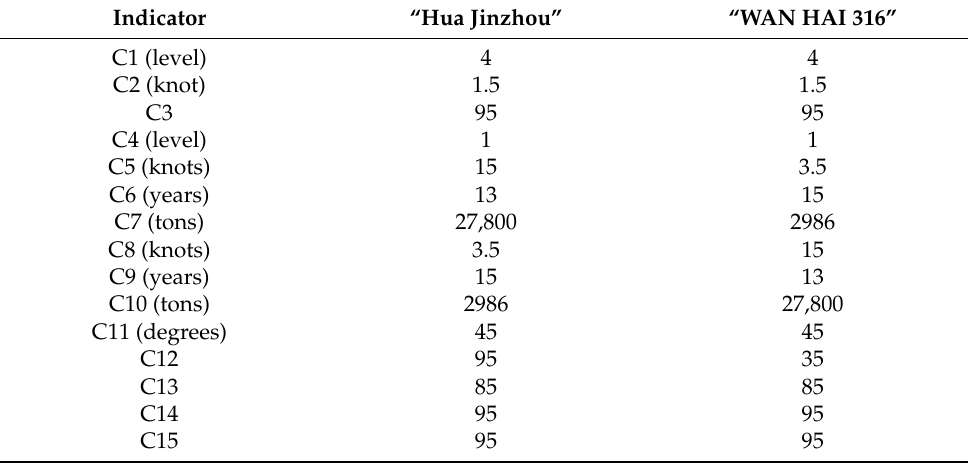
Table 6. Data of emergency situation after the collision in case